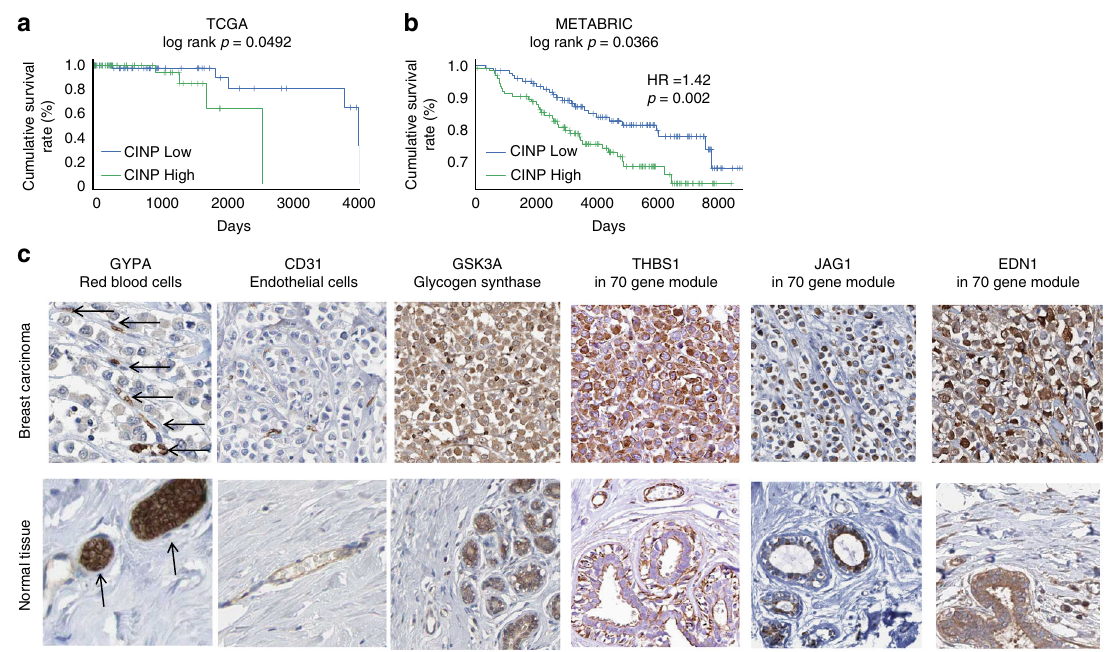
Fig. 5 The transcriptional response module associated with the collagen-induced network phenotype (CINP) is predictive of poor prognosis in human tumor datasets. a Kaplan – Meier survival analysis of stage I breast cancer patients from TCGA and b METABRIC databases, when the PC1 loadings were used as an expression metagene. High CINP refers to the highest metagene expression scores and low CINP to the lowest expression scores. HR indicates hazard ratio. c Sections of a primary breast carcinoma displaying the clinical VM phenotype of chain-like cell structures surrounded by a matrix network. Column 1: red blood cells, stained by an antibody against GYPA, are indicated by arrows. Several red blood cells are traversing the matrix surrounded by cancer cells. Column 2: tumor cells are negative for CD31 but in healthy tissue, stained regions colocalize to vessel structures. Column 3: tumor cells stain strongly for glycogen synthase, which likely contributes to the generation of a glycogen-rich matrix between the chains of cells. Columns 4 – 6: tumor cells undergoing VM stain strongly for three of the most upregulated genes in our 70-gene module. Image credit for d : Human Protein Atlas, patient ID 1910, available from www.proteinatlas.org 48 . See “ Methods ” for analysis